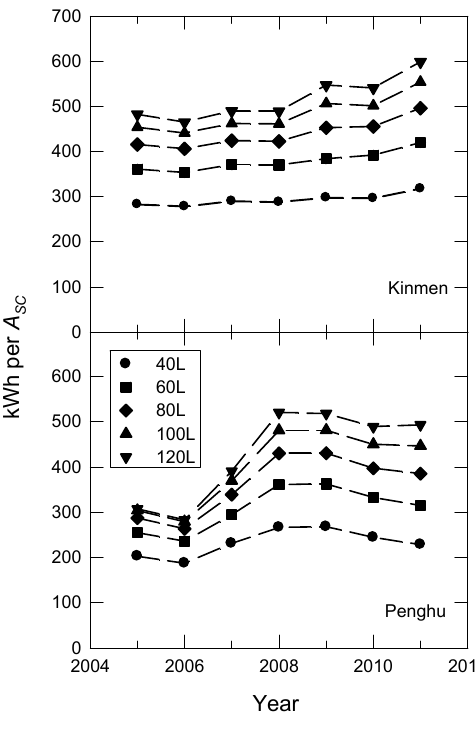
Figure 4. L / A on electricity being substituted by solar sc